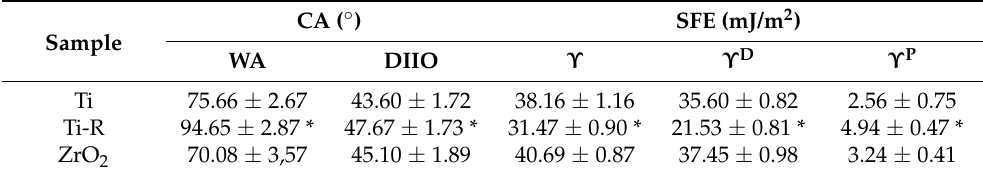
Table 3. Values (mean ± standard deviation) of contact angle of water (WA) and diiodomethane (DIIO), and the estimated surface energy ( Υ ) with their polar ( Υ P ) and dispersive ( Υ t D ) components, for each surface treatment.